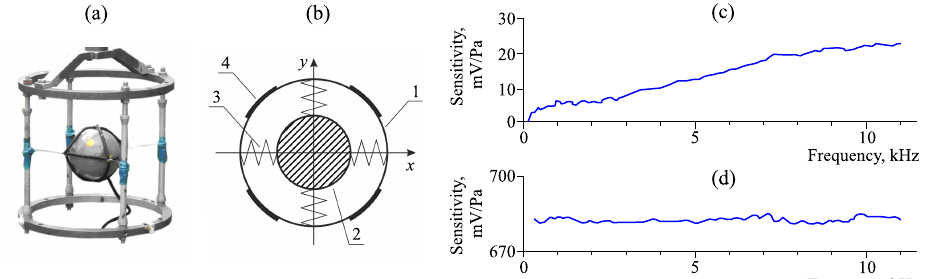
Figure 2. Combined hydroacoustic receiver: ( a ) receiver, ( b ) its block scheme. On the scheme: 1— casing, 2—inertial mass, 3—resilient elements and 4—pressure receiver components. Sensitivity of ( c ) the pressure gradient channels and ( d ) the pressure channel.